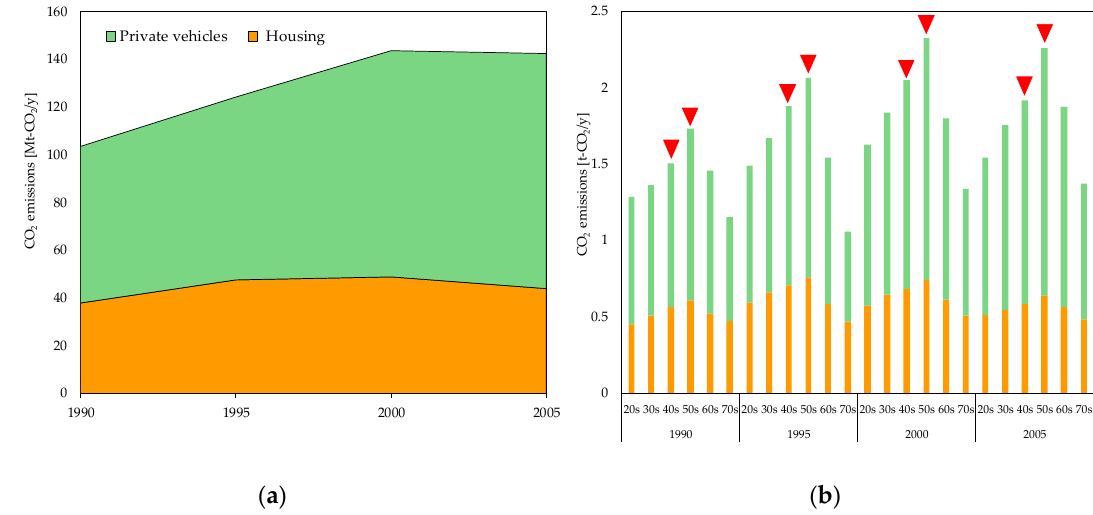
Figure 1. Sectoral composition of direct CO 2 emissions from 1990–2005. (a) Total (Mt-CO 2 /y) and (b) per capita by age group (t-CO 2 /y). Inverted triangles denote the noteworthy household age groups as detailed in the main text.